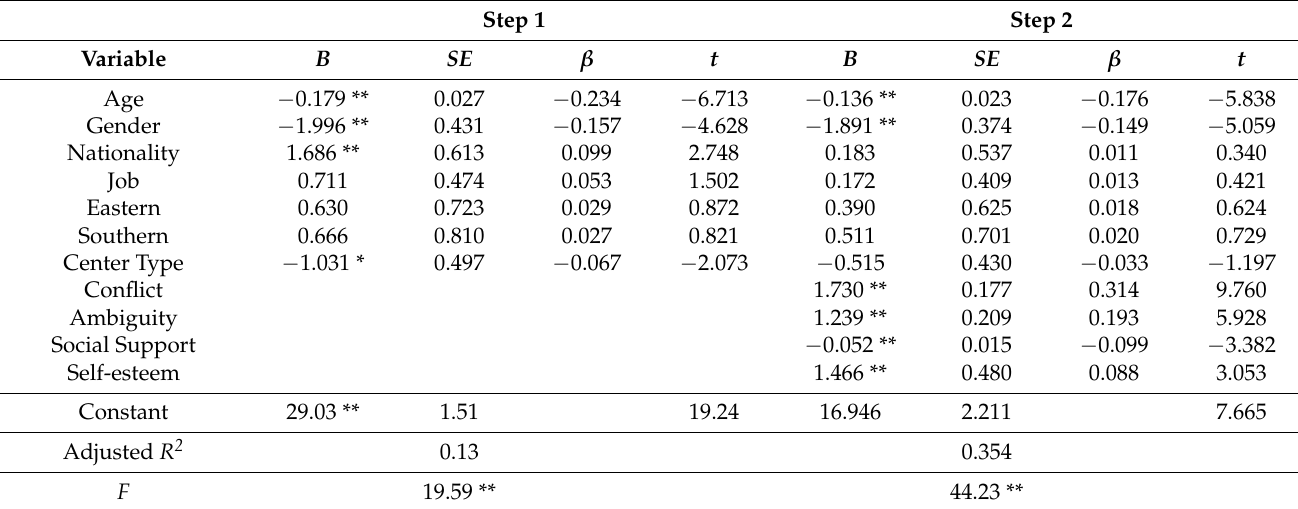
Table 3. Linear regression analysis: work-related predictors of stress.